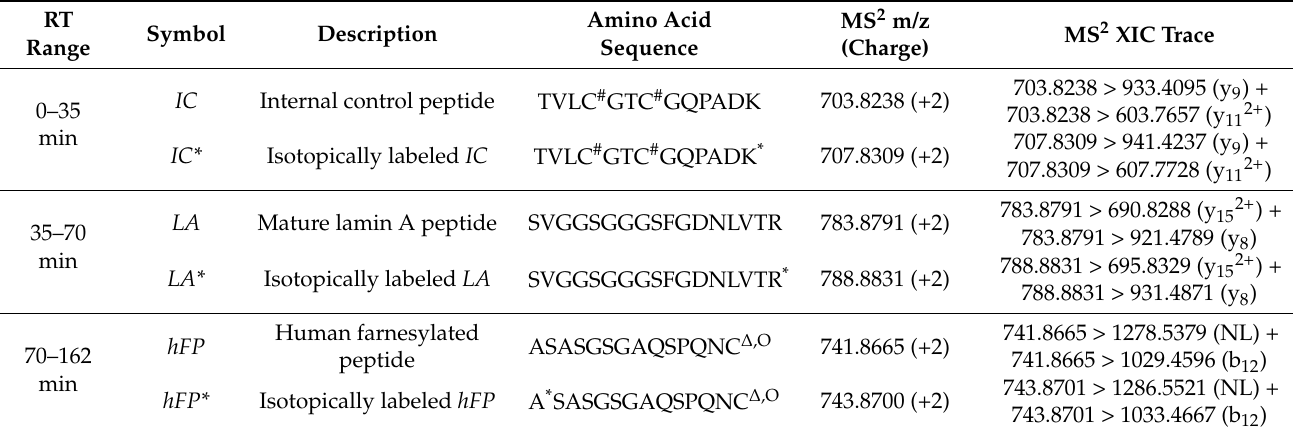
Table 3. Precursor ions traced in the PRM assay aimed at the absolute quantitation of lamin A and progerin in human